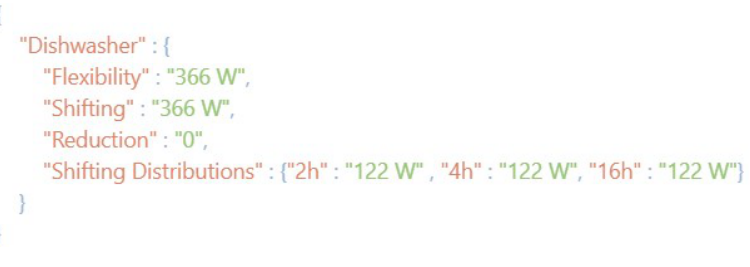
Figure 2. JSON response of end-user 2 to the demand response event at 11 h.